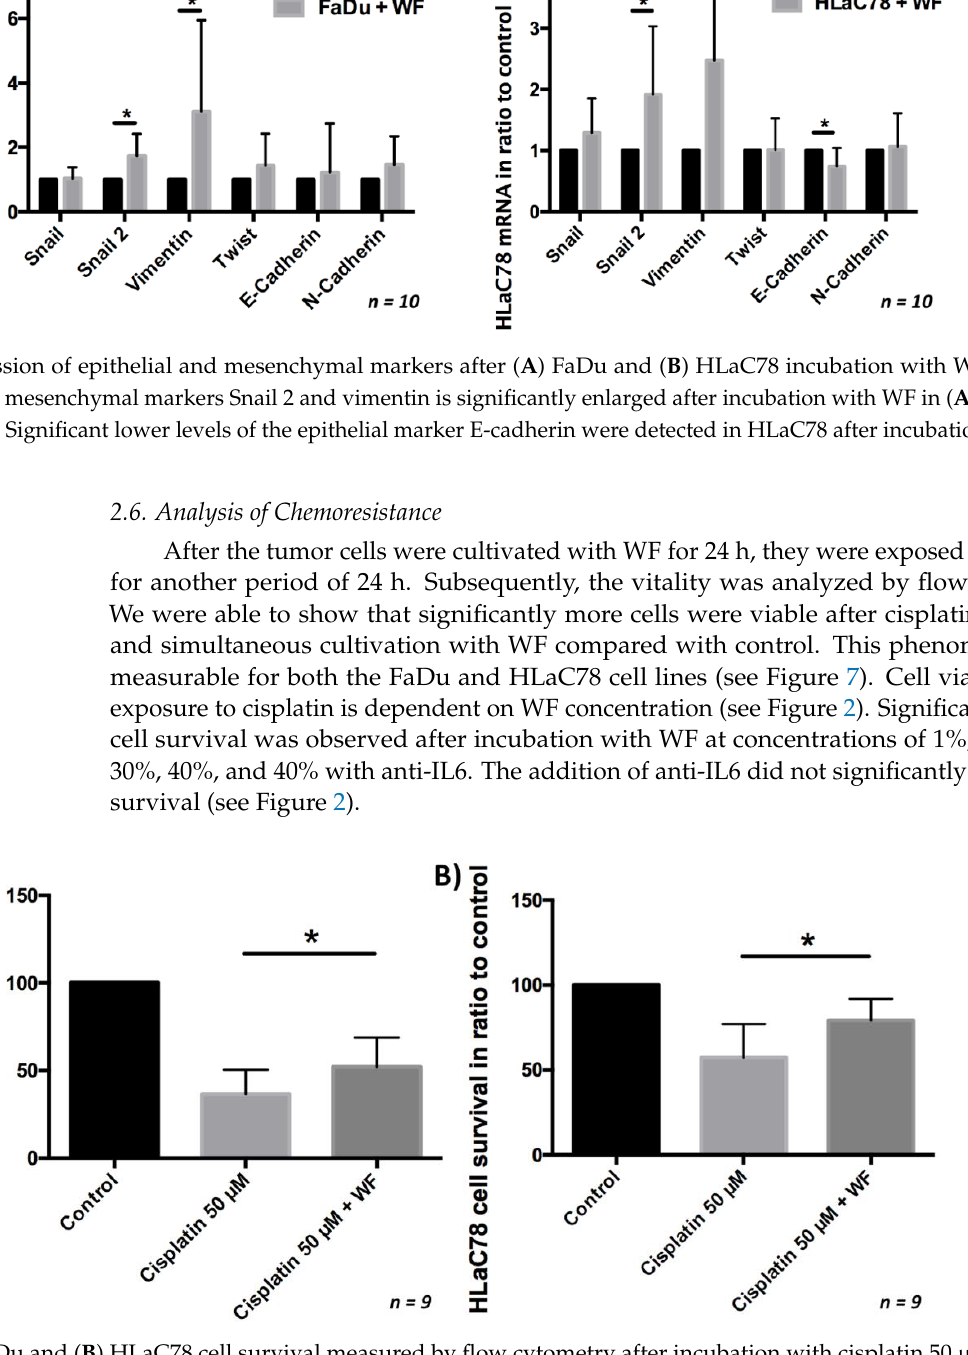
Figure 7. ( A ) FaDu and ( B ) HLaC78 cell survival measured by flow cytometry after incubation with cisplatin 50 µM and ±WF. There is significantly higher cell survival by cultivation of ( A ) FaDu and ( B ) HLaC78 with medium containing WF ( n = 9).